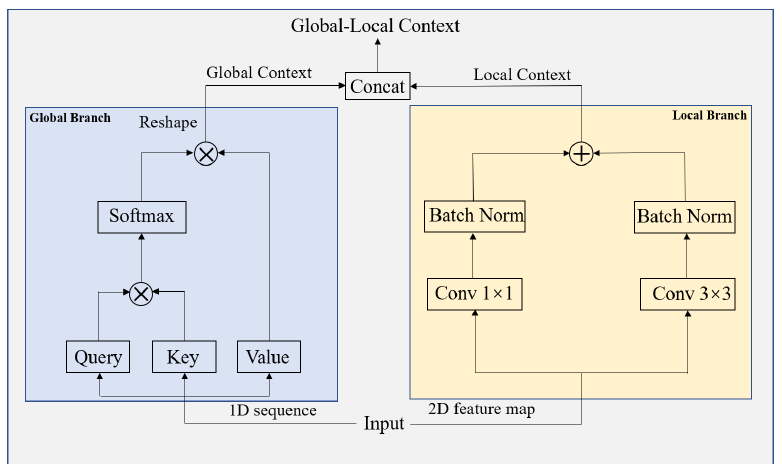
Figure 5. Specific structure design of the global–local attention